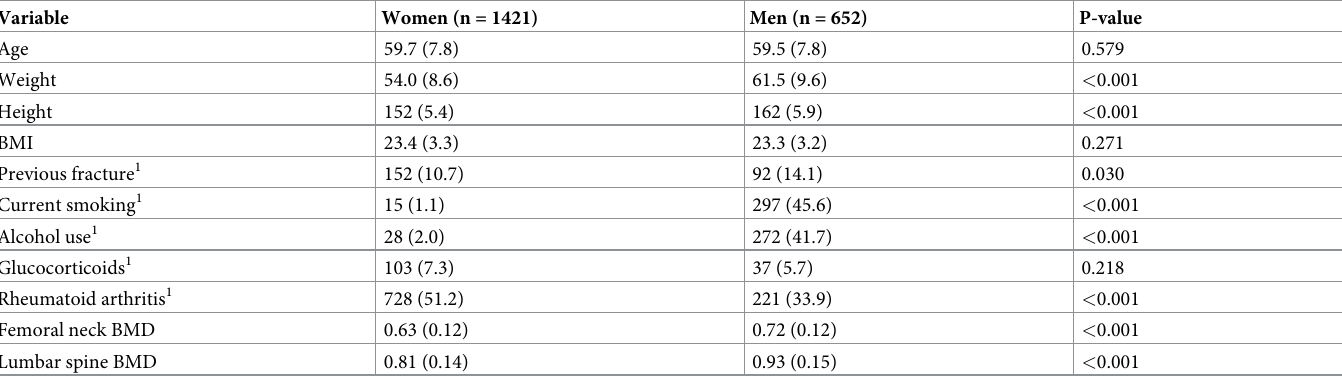
Table 1. Basic characteristics of 1421 women and 652 men.